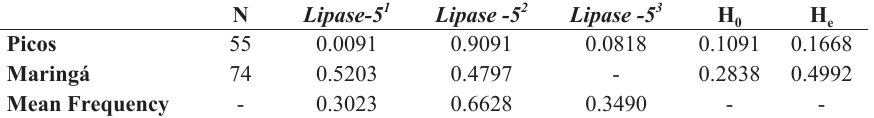
Allele frequency values for the lipase from Est-5 locus evaluated in mandacaru seeds collected in Picos-PI and Maringá-PR and the expected (H ) and observed (H ) heterozygosity values. e o